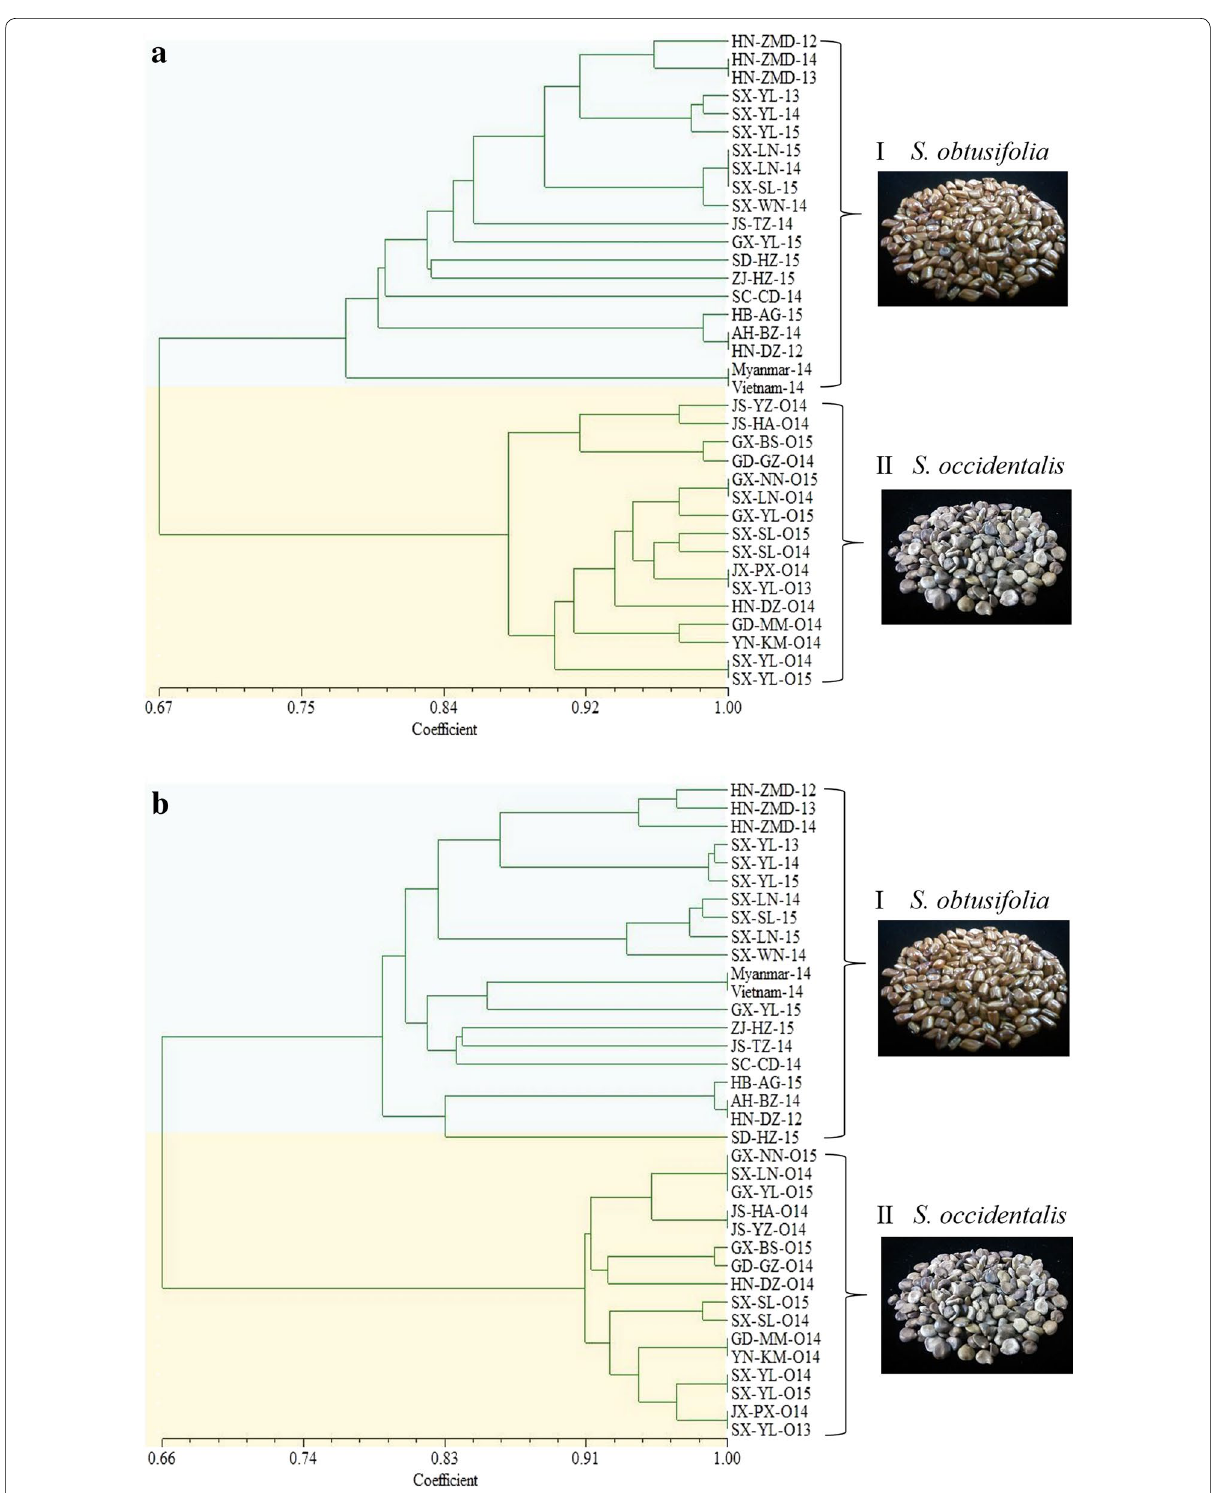
Fig. 2 UPGMA dendrograms generated based on ISSR ( a ) and SCoT ( b ). The cluster I contained 20 S. obtusifolia samples and cluster II contained 16 S. occidentalis samples, which indicated in blue and pink respectively. The photographs of S. obtusifolia and S. occidentalis were also